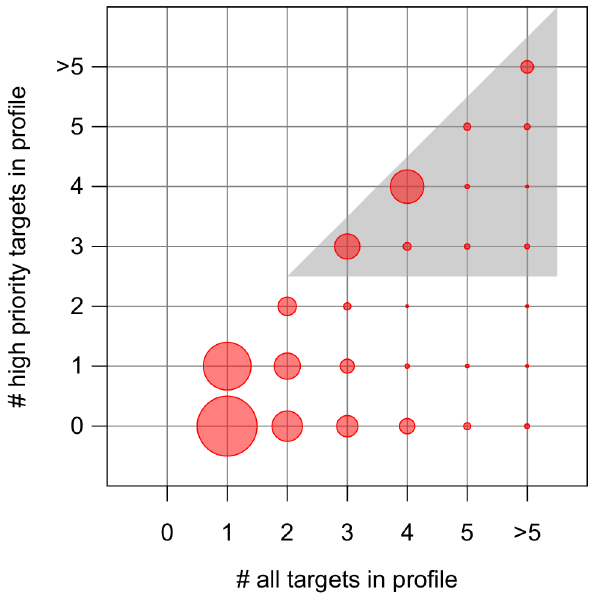
Figure 5. High priority targets versus total number of targets within a predicted profile. The size of a circle relates to the number of compounds that address a profile of the given characteristics.